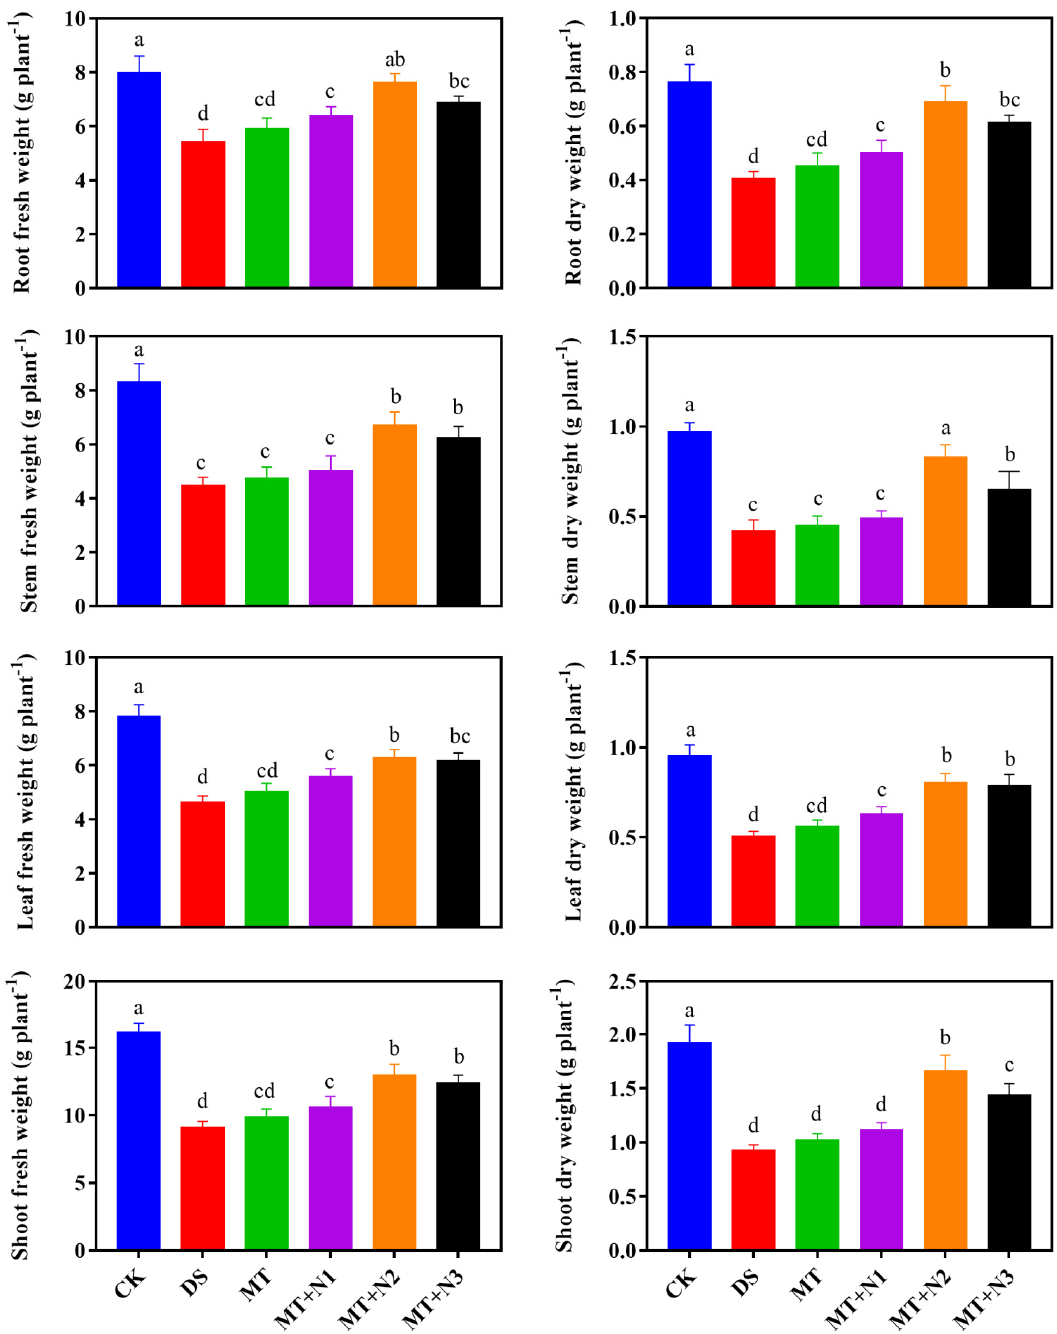
Figure 1. Fresh- and dry biomass accumulation of root, stem, leaf, and shoot of maize seedlings under drought-stress conditions in combination with melatonin in different levels of nitrogen. CK; Well-watered control without melatonin (MT), DS; Drought stress without MT, MT; Drought stress + 100 µ M MT, MT + N1; MT 100 µ M + 200 kg N ha − 1 , MT + N2; MT-100 µ M + 250 kg N ha − 1 , and MT + N3; MT-100 µ M + 300 kg N ha − 1 . Vertical bars represent ± S.D. ( n = 3, biological replicates). Different letters indicate significant differences as determined by the LSD test ( p ≤ 0.05).